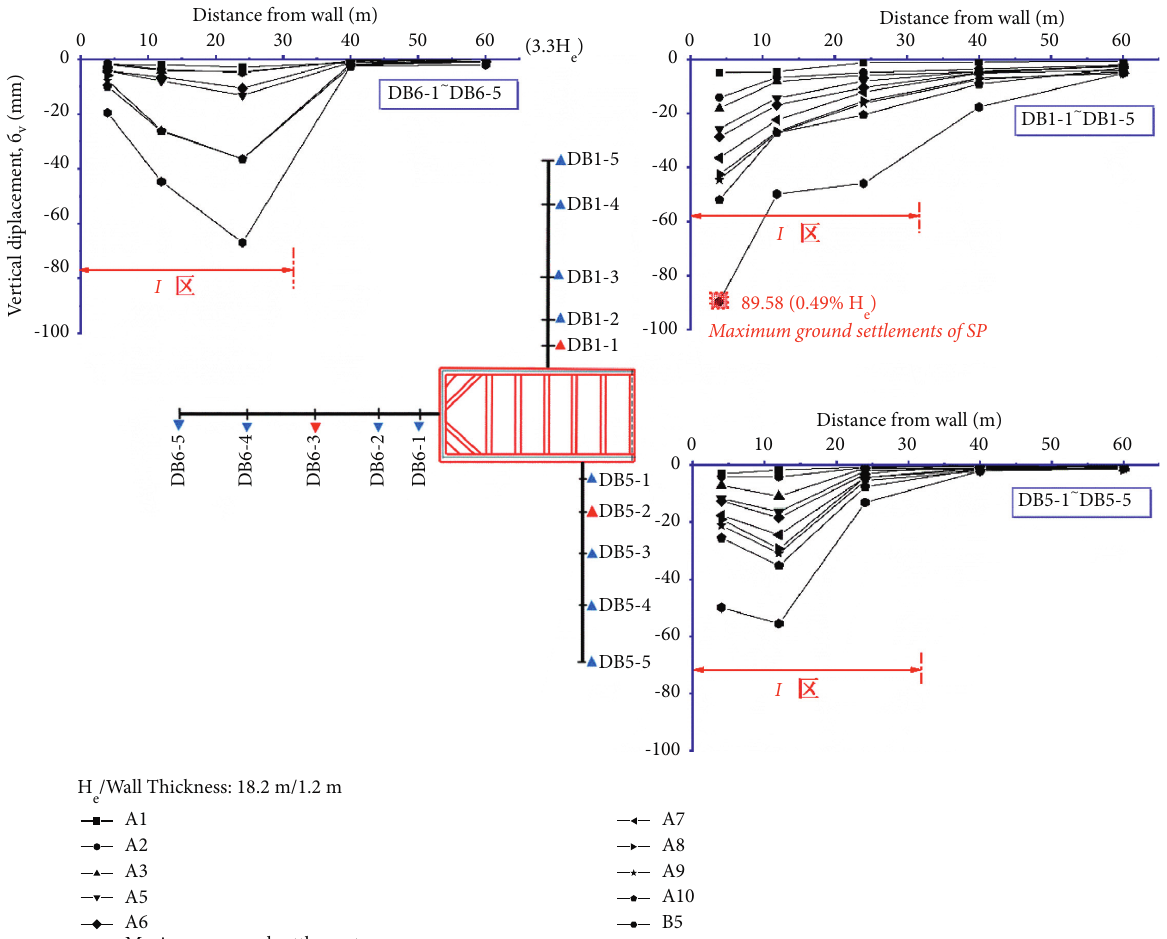
Figure 12: Ground surface settlements of SP.